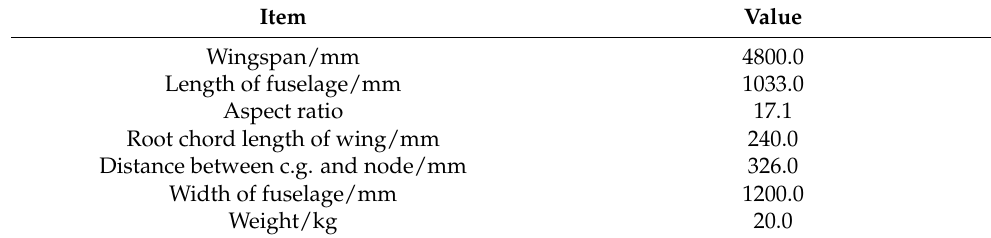
Figure 2. Aircraft FEM model. Table 1. Design parameters.